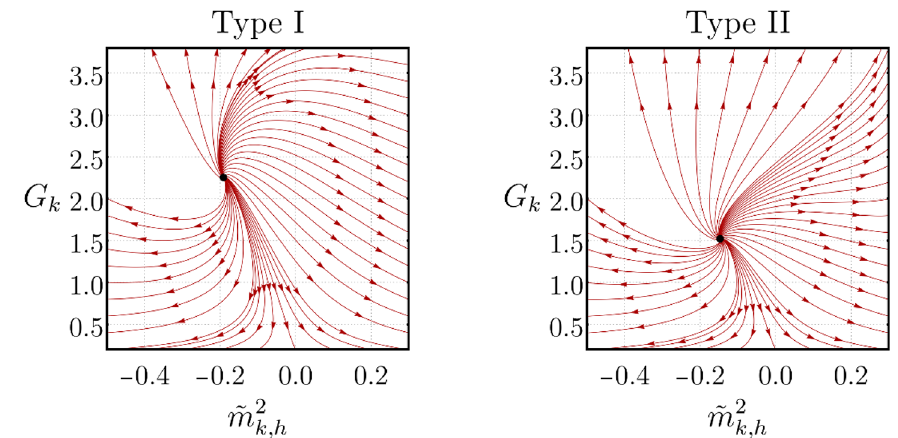
Figure 6 . Flow diagram for unimodular quantum gravity in the single mass approximation. The RG trajectories correspond to numerical solutions of eqs. (4.2) and (B.6). As usual, the arrows point towards the infrared. In the single mass approximation, we found (cid:12)xed point